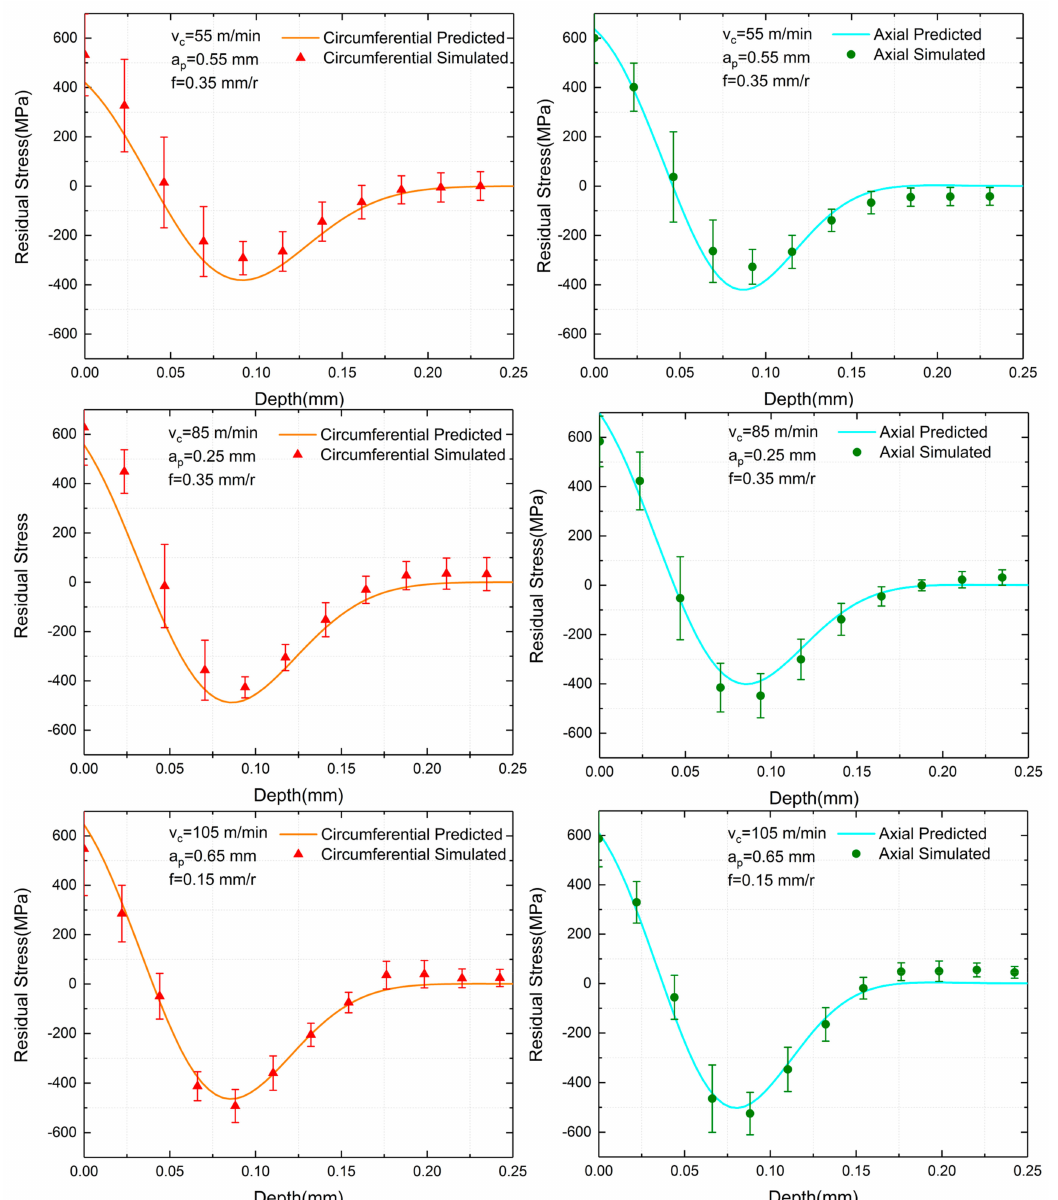
Figure 9. The comparation of predicted and simulated residual stress